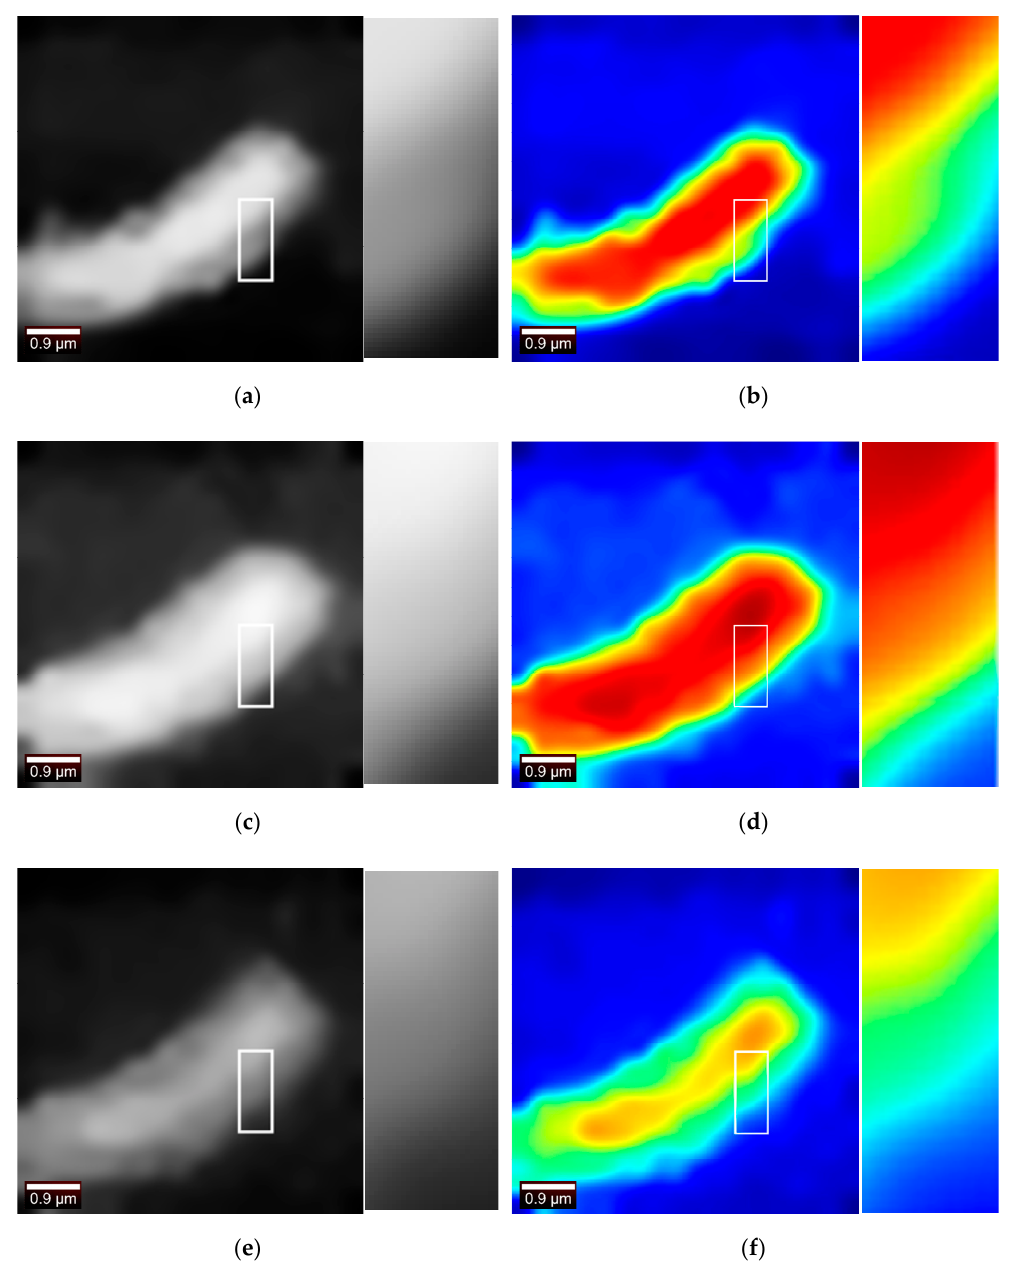
Figure 17. ( a,b ) Imaging in the band 50–2750 (cm − 1 ) ( c,d ) Imaging in the band 2750–3050 (cm − 1 ) ( e,f ) Figure 17. ( a , b ) Imaging in the band 50–2750 (cm − 1 ) ( c , d ) Imaging in the band 2750–3050 (cm − 1 ) ( e , f ) Imaging in the band 3050–3950 (cm − 1 ). Imaging in the band 3050–3950 (cm − 1